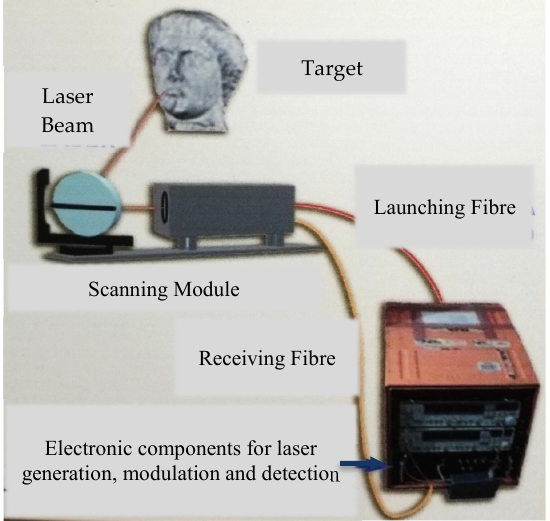
Figure 1. Scheme of the ITR technology: by the use of custom software, the scanning process is remotely controlled by a laptop connected to the electronic components. The laser beam (infrared (IR) or in the visible range-RGB) is generated by laser sources, modulated and amplified by lock-in techniques. Through optical fibers, the lasers are carried inside the optical head, where a system of lenses collimates and focalizes the ray on the center of a movable scanning mirror, which drives the incident laser beam on the surface’s object and collects the backscattered beam, elaborated with custom software.